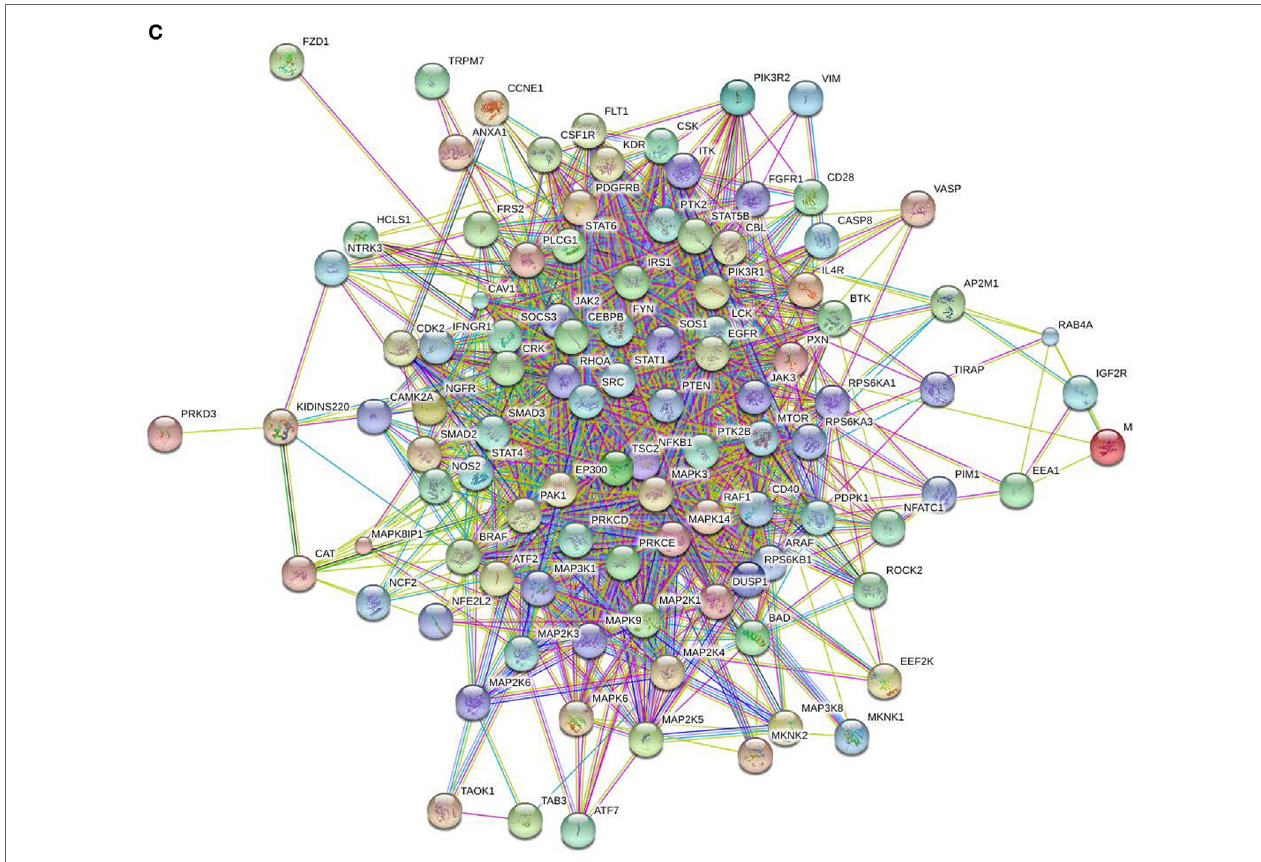
FigUre 2 | Protein–protein interactions. Predicted protein–protein interactions generated following analysis of significantly different peptides input into the STRING database: (c) middle low interactions.